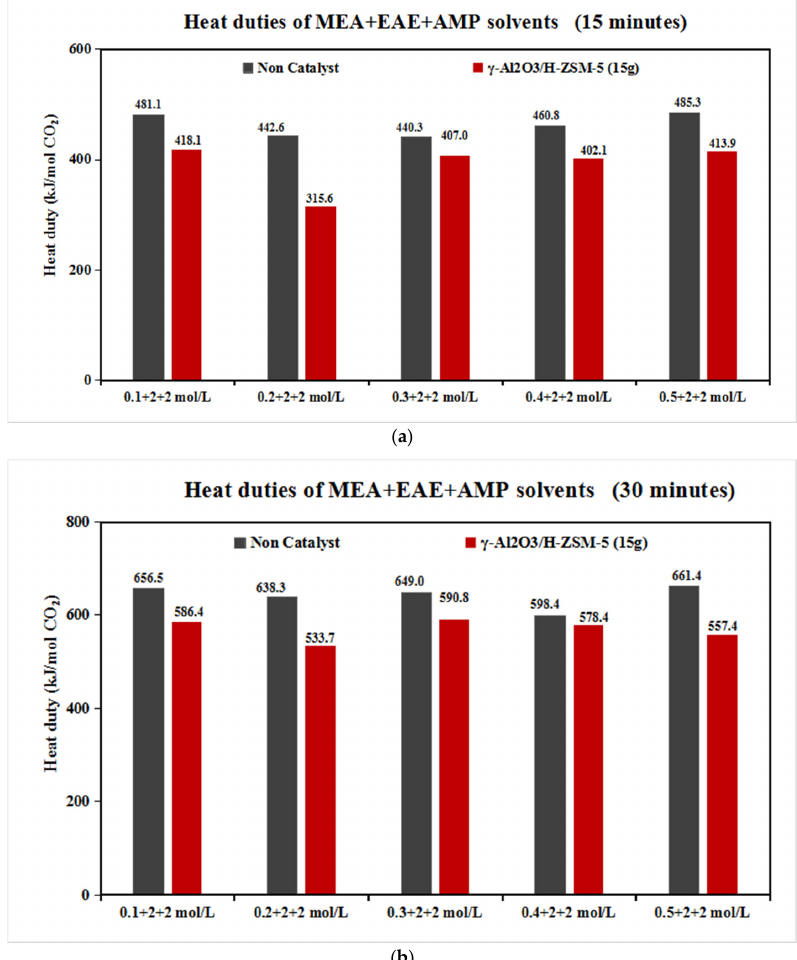
Figure 3. The heat duties of MEA + EAE + AMP at 0.1–0.5 + 2 + 2 mol/L with various catalysts: ( a ) 15 min, ( b ) 30 min.